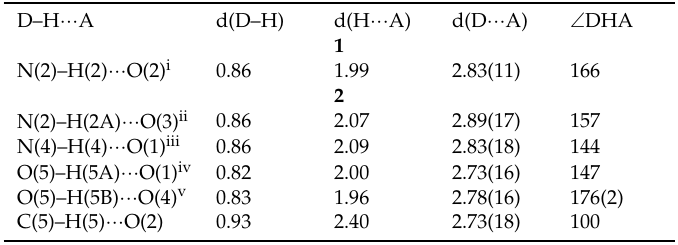
Table 2. Hydrogen bond lengths (Å) and bond angles ( º ) for 1 and 2